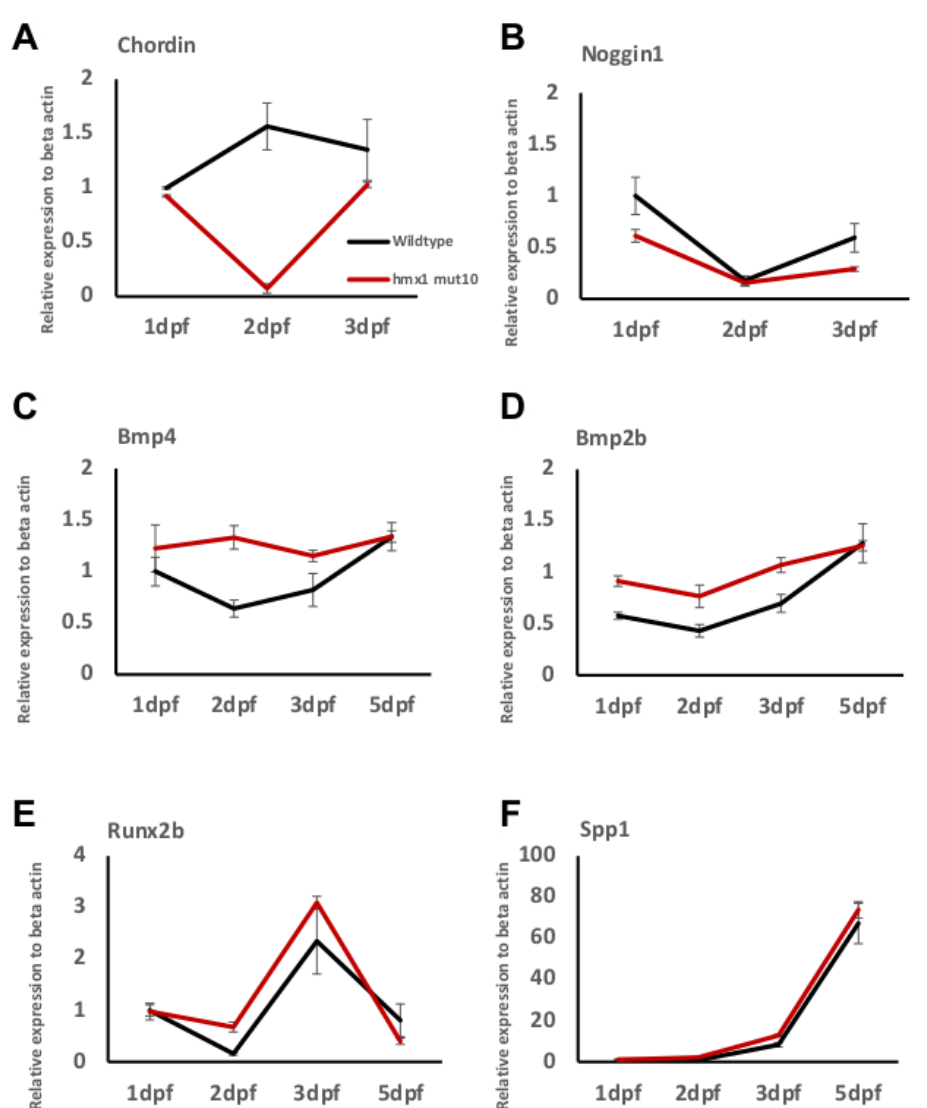
Figure 3. Hmx1 mut10 embryos present enhanced expression of osteogenic factors: RT-PCR analysis of the BMP antagonist chordin and noggin1 relative to β -actin, the osteogenic inducers bmp2b and bmp4 , and the osteogenic markers runx2b and spp1 . In hmx1 mut10 embryos, chordin expression is reduced at 2 dpf ( A ), while noggin1 expression is lower at 1 dpf and 3 dpf ( B ). Bmp2b and bmp4 transcripts are significantly different in hmx1 mut10 embryos when compared to wildtype zebrafish from 1 dpf to 3 dpf ( C , D ). The osteogenic markers runx2b and spp1 are differentially expressed, and are higher in hmx1 mut10 at 2 dpf and 3 dpf, respectively ( E , F ). Data are expressed as mean of three or more experi-